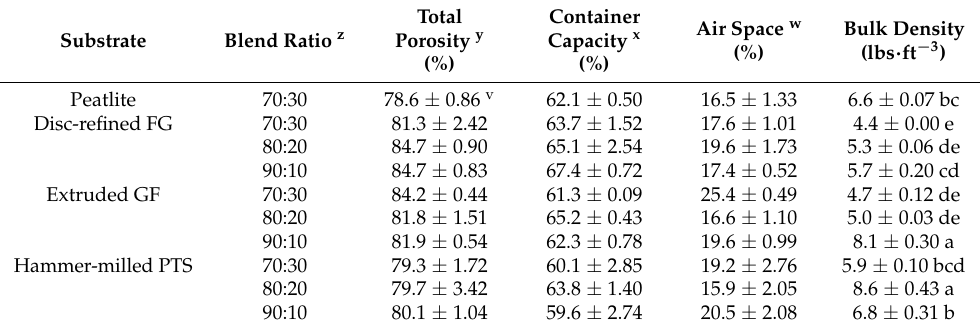
Table 3. Mean physical properties ± standard error ( n = 3) at seeding for each substrate treatment in objective